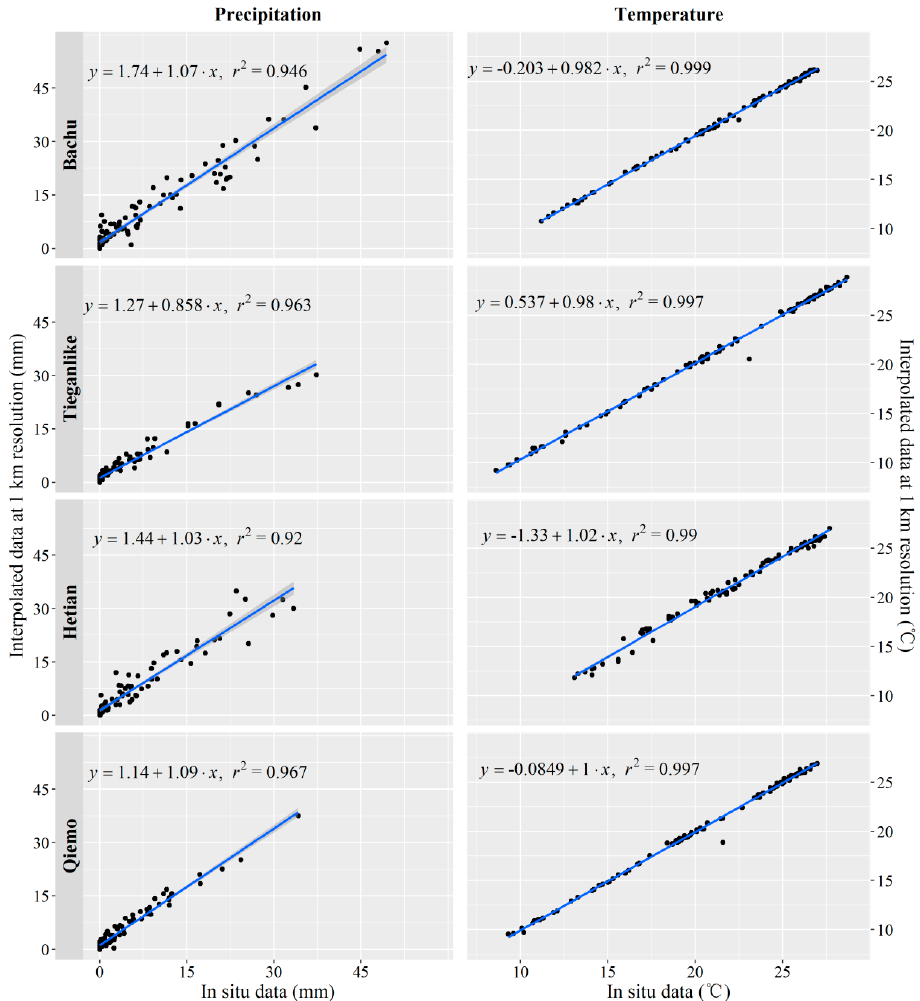
Figure 5. Scatterplots of the interpolated climate data against the in-situ data at four weather stations.